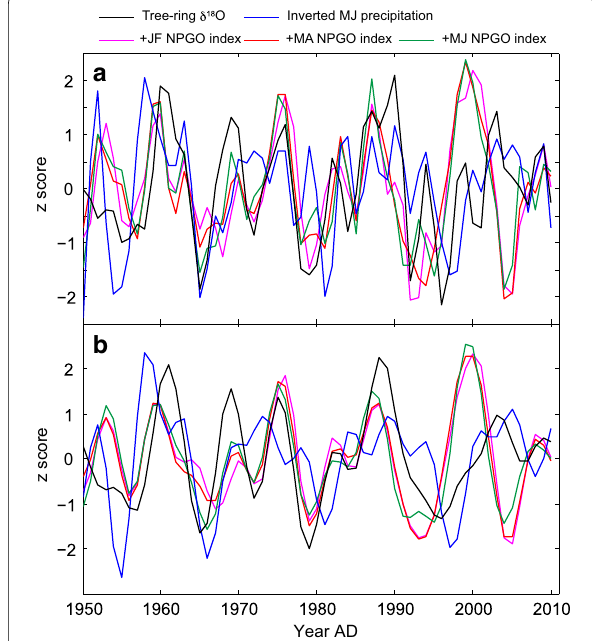
Fig. 5 a 3–30-year variability of tree-ring δ 18 O (black line), inverted MJ precipitation in Sendai (blue line), line), and MJ (green line) NPGO index. b Same as a , except for 5–30- + year variability